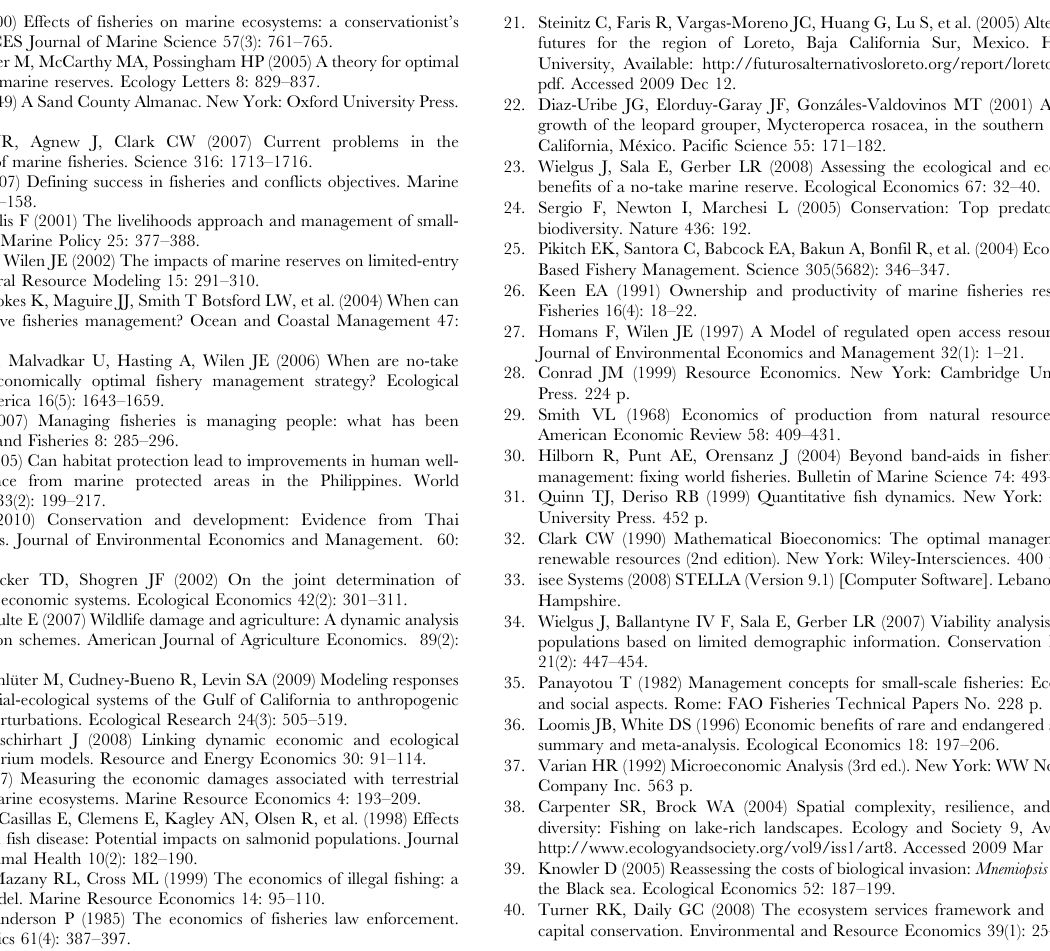
Table S5 Sensitivity analysis of parameters used in simulation model. Each parameter was increased by 5% to determine the relative impact on fish stock and the wage